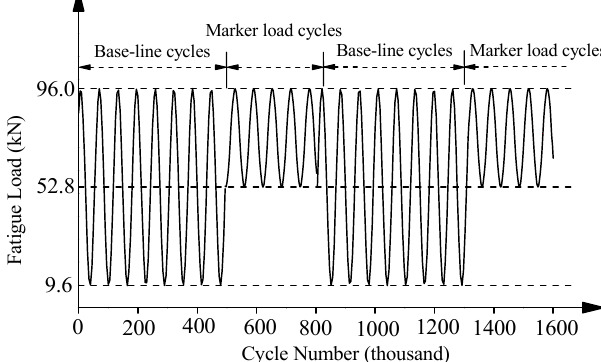
Figure 2. Fatigue loading cycles adopted in “beach marking”